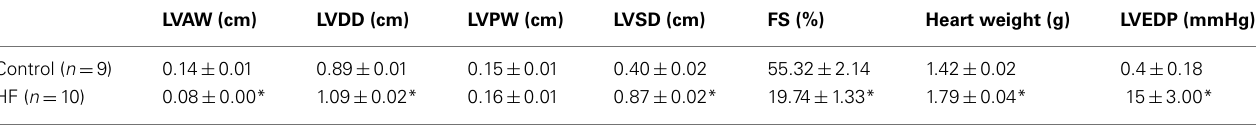
Table 1 | Echocardiographic and cardiac characteristics.